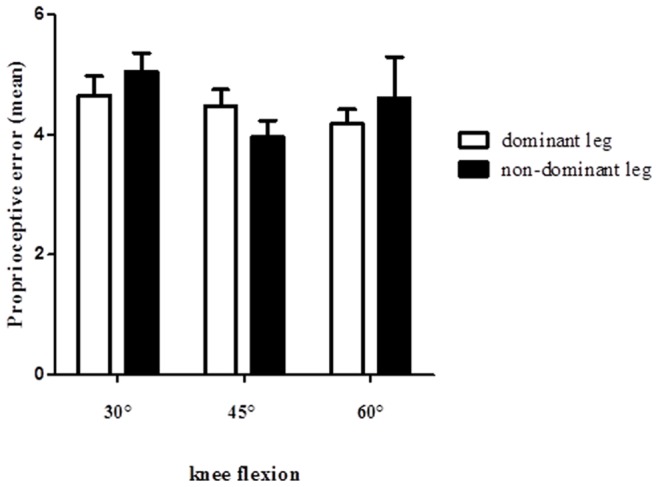
Proprioceptive errors in dominant and non-dominant legs.